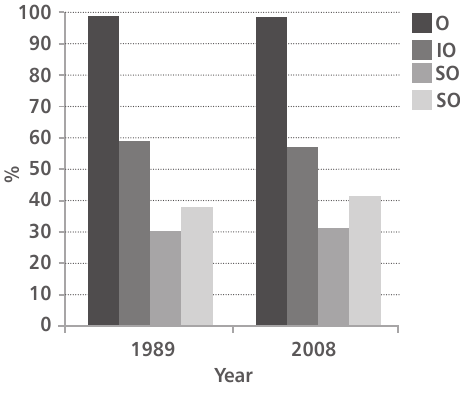
FIGURE 4. Comparison of narrow-leaved ash damage indicators for two surveying periods